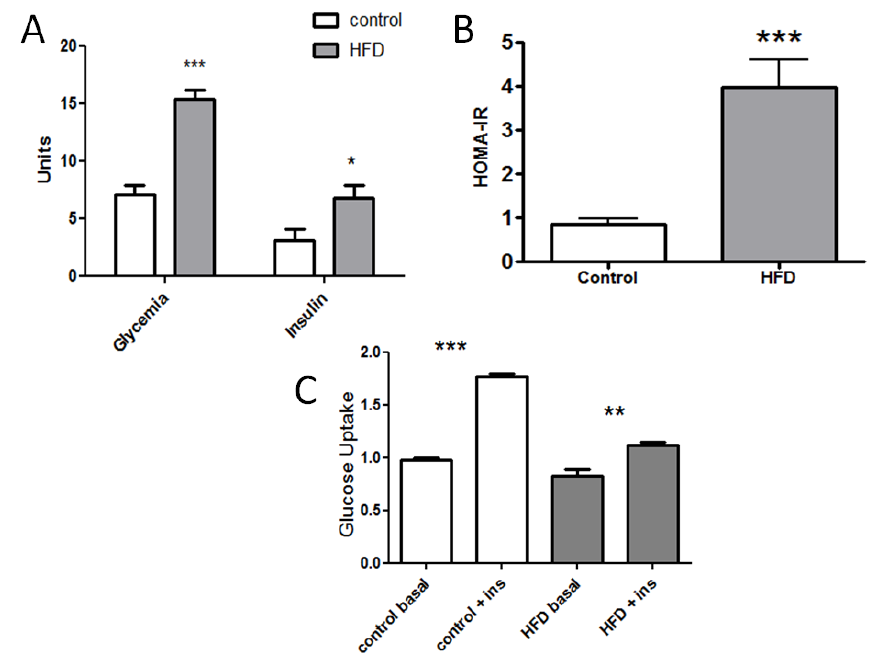
Figure 1. Treatment with a high fat diet during eight weeks induced insulin resistance in mice. ( A ) Glycemia (mmol/L) and insulin ( μ U/mL) concentration obtained after 14 h fasting ( n = 17, t -Student, * = p < 0.02); ( B ) Insulin resistance condition determined by the homeostasis model of assessment-insulin resistance (HOMA-IR) in both control and high fat diet (HFD) mice ( n = 15, t -Student, * = p < 0.023); ( C ) Glucose uptake induced by insulin. Cultured skeletal fibers were loaded with 2 -NBDG during 15 min, and then, fluorescence images were acquired. The graph represents relative fluorescence with respect to basal control. Insulin (ins) treated fibers were pre-incubated during 15 min with 100 nM of insulin ( n = 6, ANOVA, * p < 0.05, ** p < 0.01, *** p <